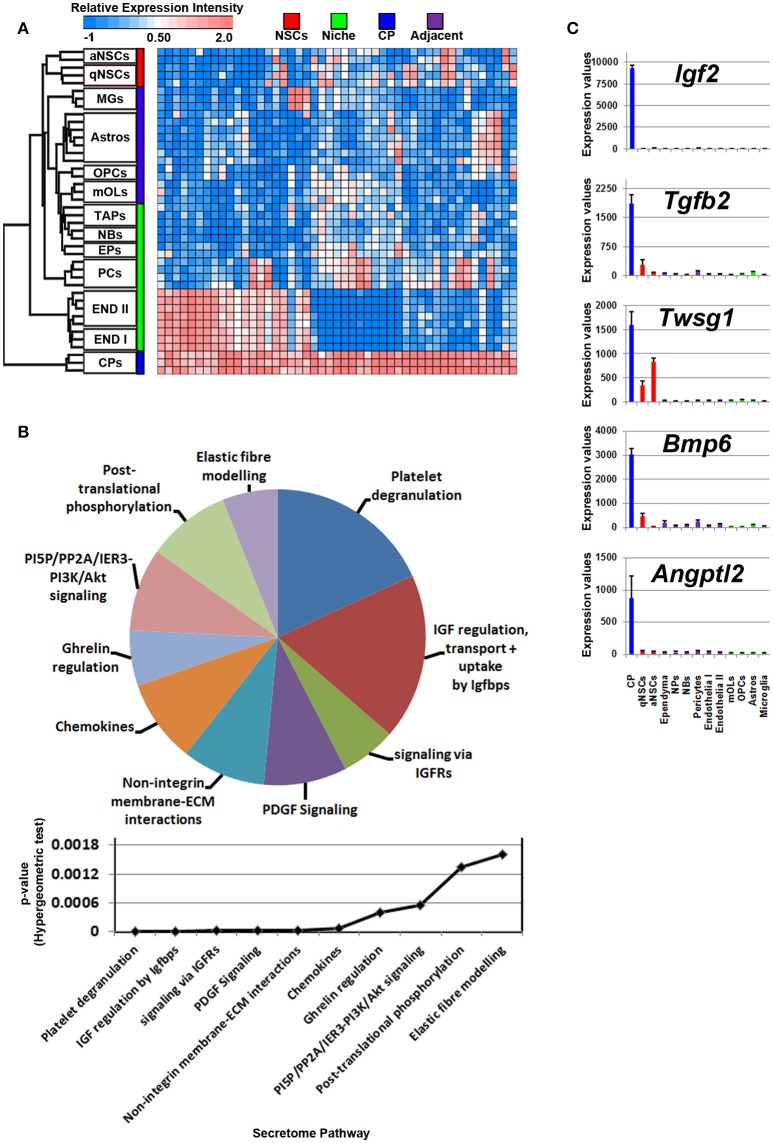
Ligand mRNA enrichment in the CP. (A) The transcriptome of ligand mRNA significantly enriched (1.8 fold change; p < 5% FDR) in the CP are displayed as a heatmap and plotted with the remaining datasets. Some ligand genes are abundant in the CP with some shared expression in vasculature. (B) These were further characterized using Reactome Pathway for classifying broadly the functions and signaling networks of ligand mRNA detected in the analysis and their p-values plotted below as a histogram. (C) The top most enriched genes are shown in histograms with in their antilog expression values across multiple cell types showing overall elevated expression in the CP. Red, green, blue and purple colors used are for groups containing NSCs, niche, choroid plexus and adjacent glial cells, respectively. CP, choroid plexus; aNSCs, active neural stem cells; qNSCs, quiescent neural stem cells; MGs, microglia; OPCs, oligodendrocytes precursor cells; Astros, astrocytes; OLs, oligodendrocytes (mature); NBs, neuroblasts; TAPs, transiently amplifying progenitors; EPs, ependymal; PCs, pericytes; END I, Endothelia 1; END II, Endothelia 2.